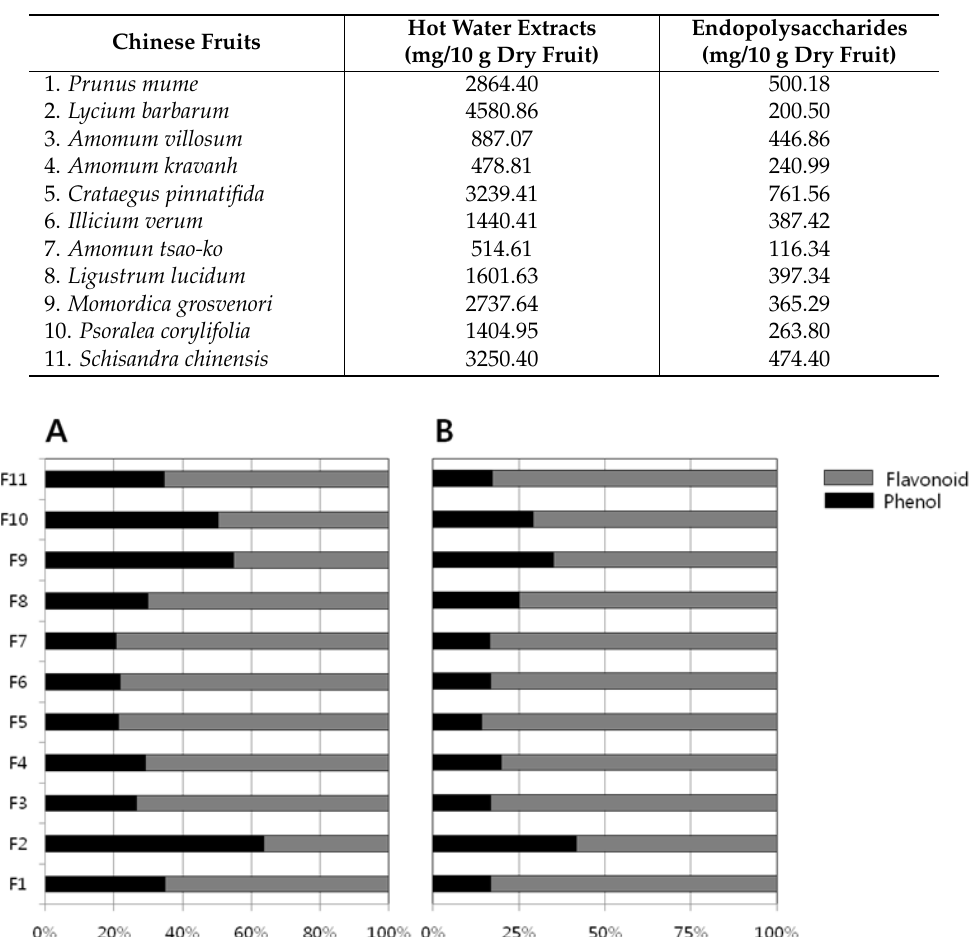
Figure 1. Proportional relation (%) of flavonoids content to phenolic content in the fruit extracts. ( A ) Hot water extracts; ( B ) Endopolysaccharides.